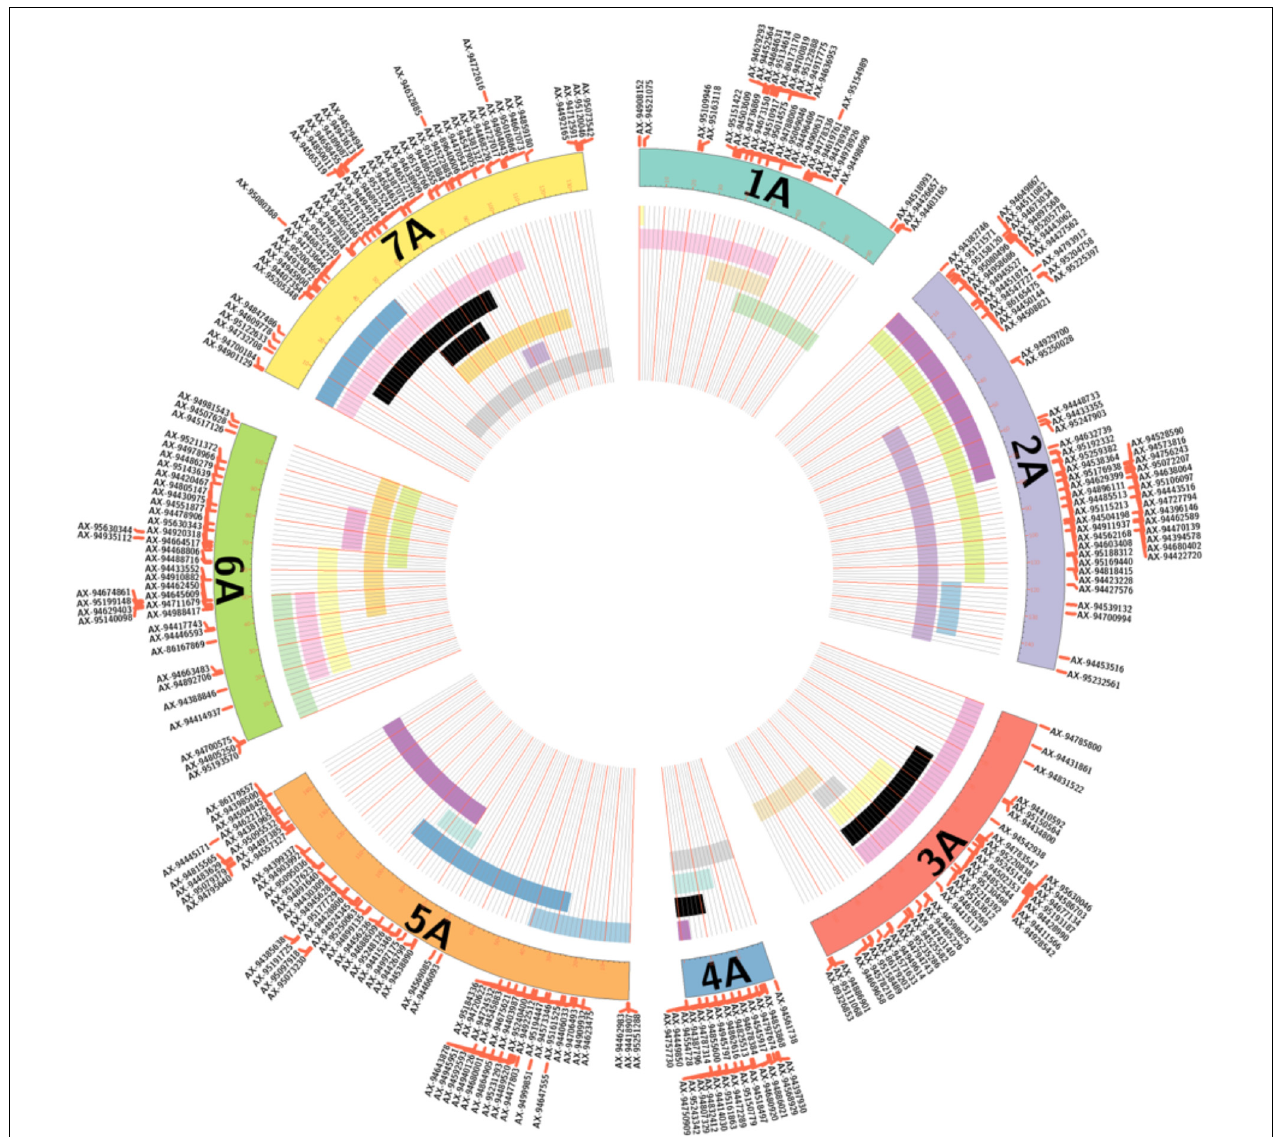
FIGURE 4 | A graphical representation of various sized segments of T. urartu , along its linkage map, in introgression lines involved in panel selection. For each of the seven LGs, the map positions of the corresponding molecular markers are reported. Black bars represent single chromosome segments of T. urartu detected in the introgression lines, while bars with the same color indicate multiple chromosome segments of T. urartu detected in a single introgression line. In total, 17 lines with overlapping segments that covered the entire genome of T. urartu were selected for a panel of lines that would undergo self-fertilization for downstream trait